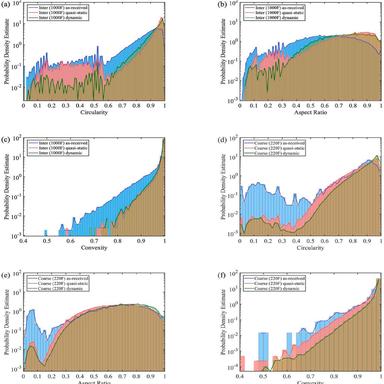
Particle morphological distribution with probability density functions of (a) circularity, (b) aspect ratio and (c) convexity for the intermediate powder; probability density functions of (d) circularity, (e) aspect ratio and (f) convexity for the coarse powder. Note that the legend in each figure indicates the deformation condition with the blue curves the as-received distributions. The red and green curves represent distributions for quasi-static loaded powders by MTS and dynamic compacted powders by Kols